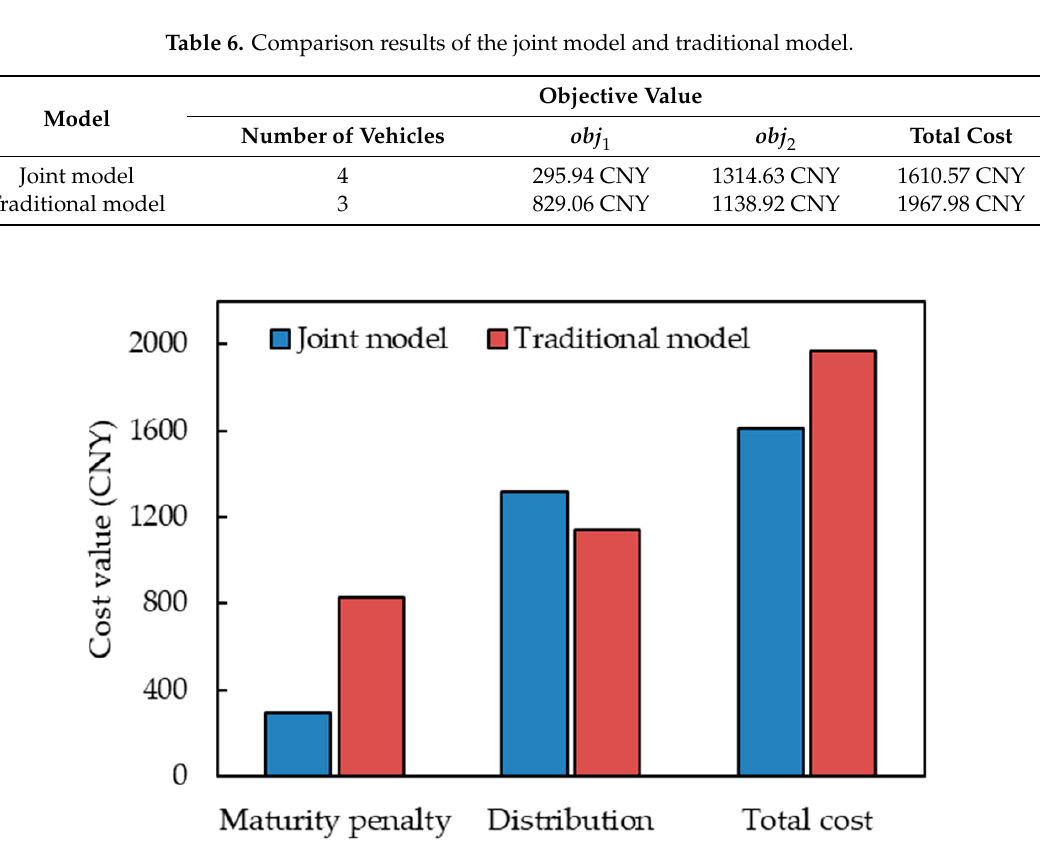
Figure 7. Cost values of the optimal scheduling from joint model and traditional model.